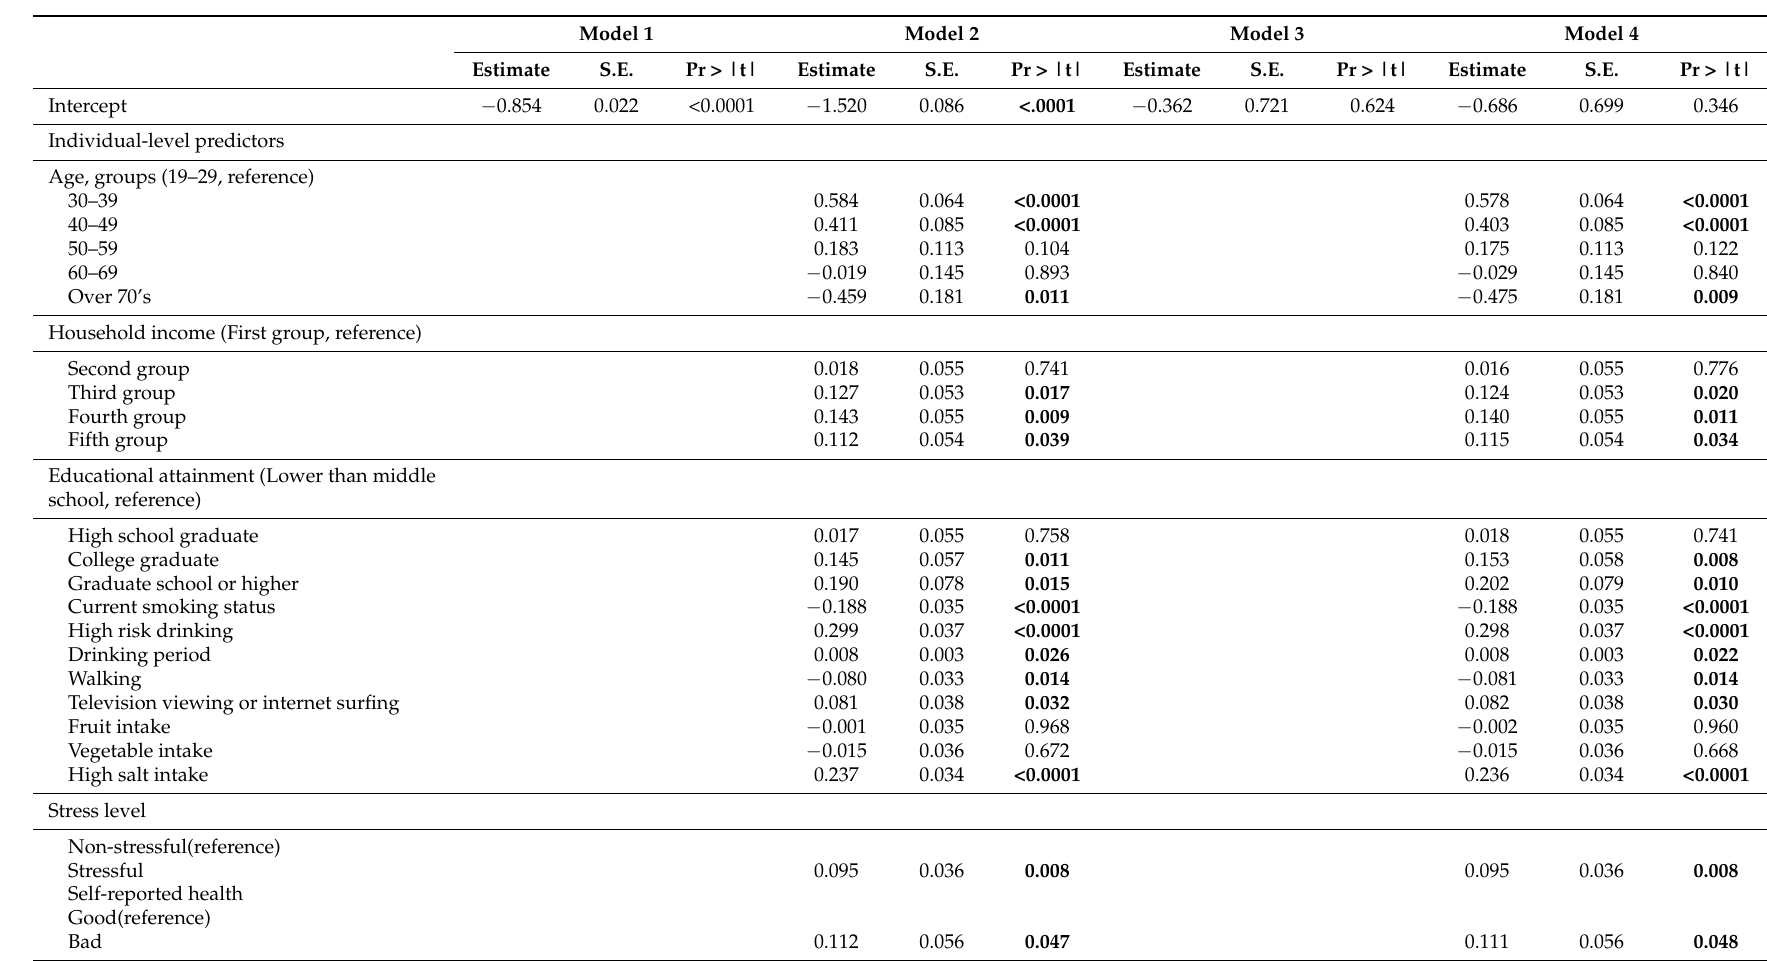
Table 2. Individual and environmental factors affecting obesity of men in Seoul based on multilevel analysis